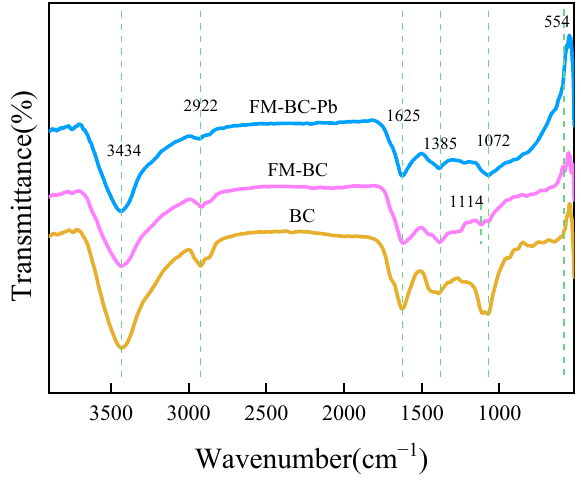
Figure 3. FTIR spectrums of biochar.